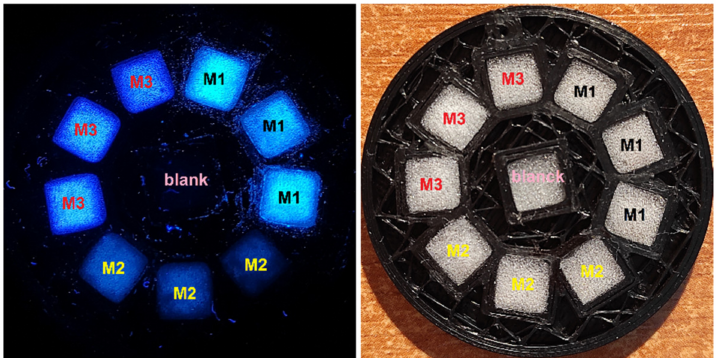
Figure 10. Sensor element cartridge under UV ( left ) and visible ( right ) illumination.